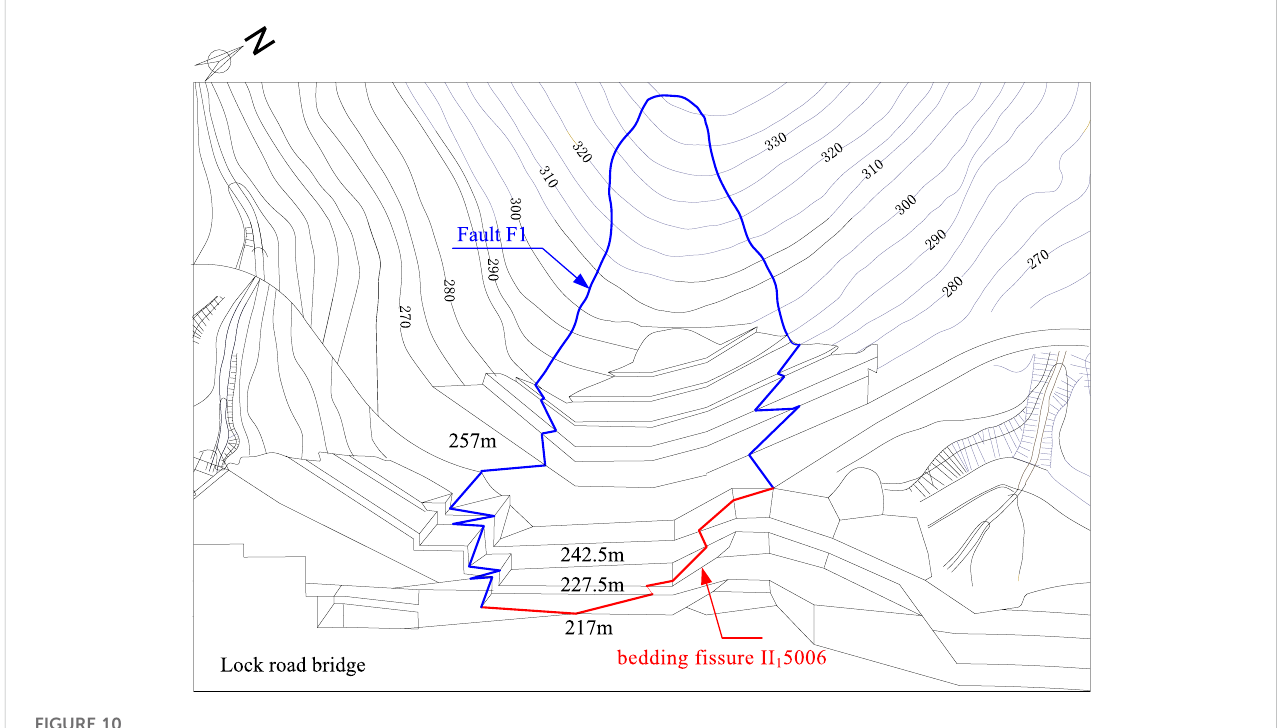
FIGURE 10 Plan layout of excavation on the right dam